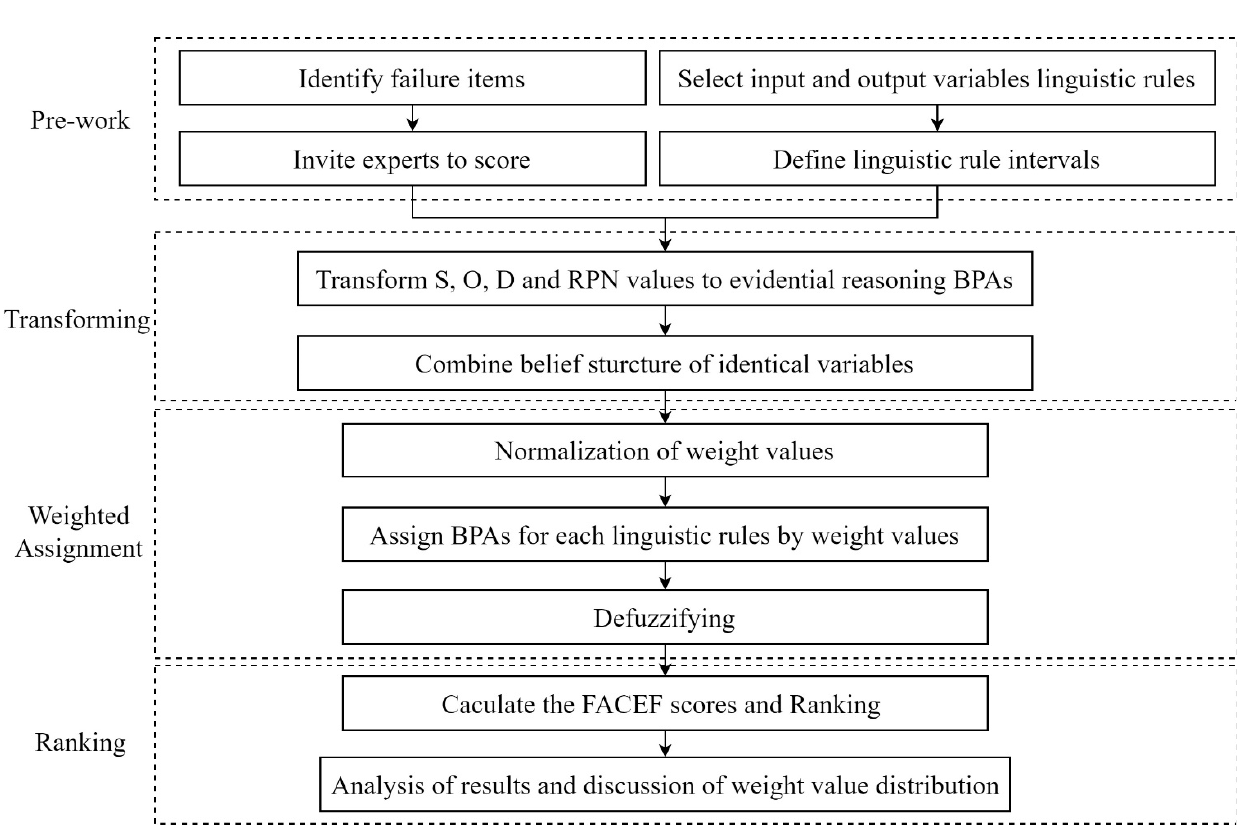
( l ) Figure 3. Typical failure patterns in sewer pipes. ( a ) Crack, ( b ) Fracture, ( c ) Broken, ( d ) Mismatch, ( e ) Deformation, ( f ) Branch Pipe Concealed Connection, ( g ) Corrosion, ( h ) Obstruction, ( i ) Leakage, ( j ) Penetration, ( k ) Root Intrusion and ( l ) Stump Walls and Roots.